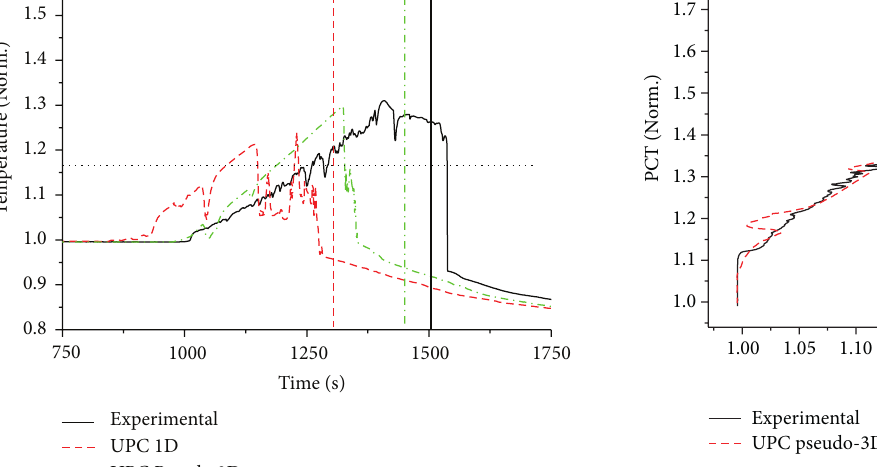
Figure 12: PCT versus CET